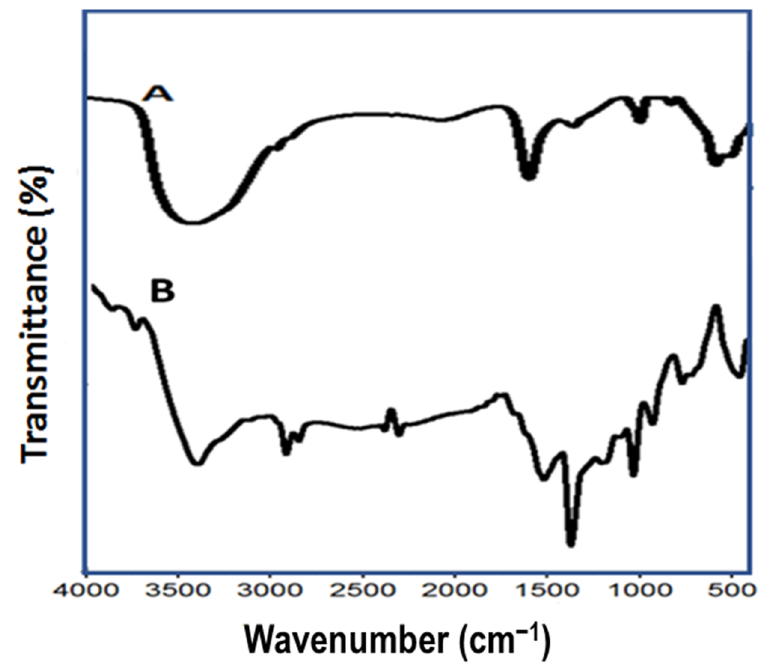
Figure 4. FTIR spectra of ( A ) ZnO and ( B ) ZnO–Ag/PPy